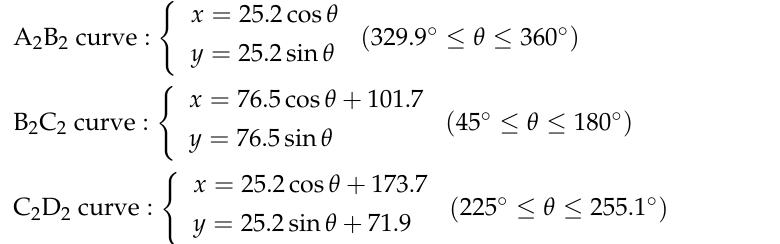
Figure 13. Profile of track surface.